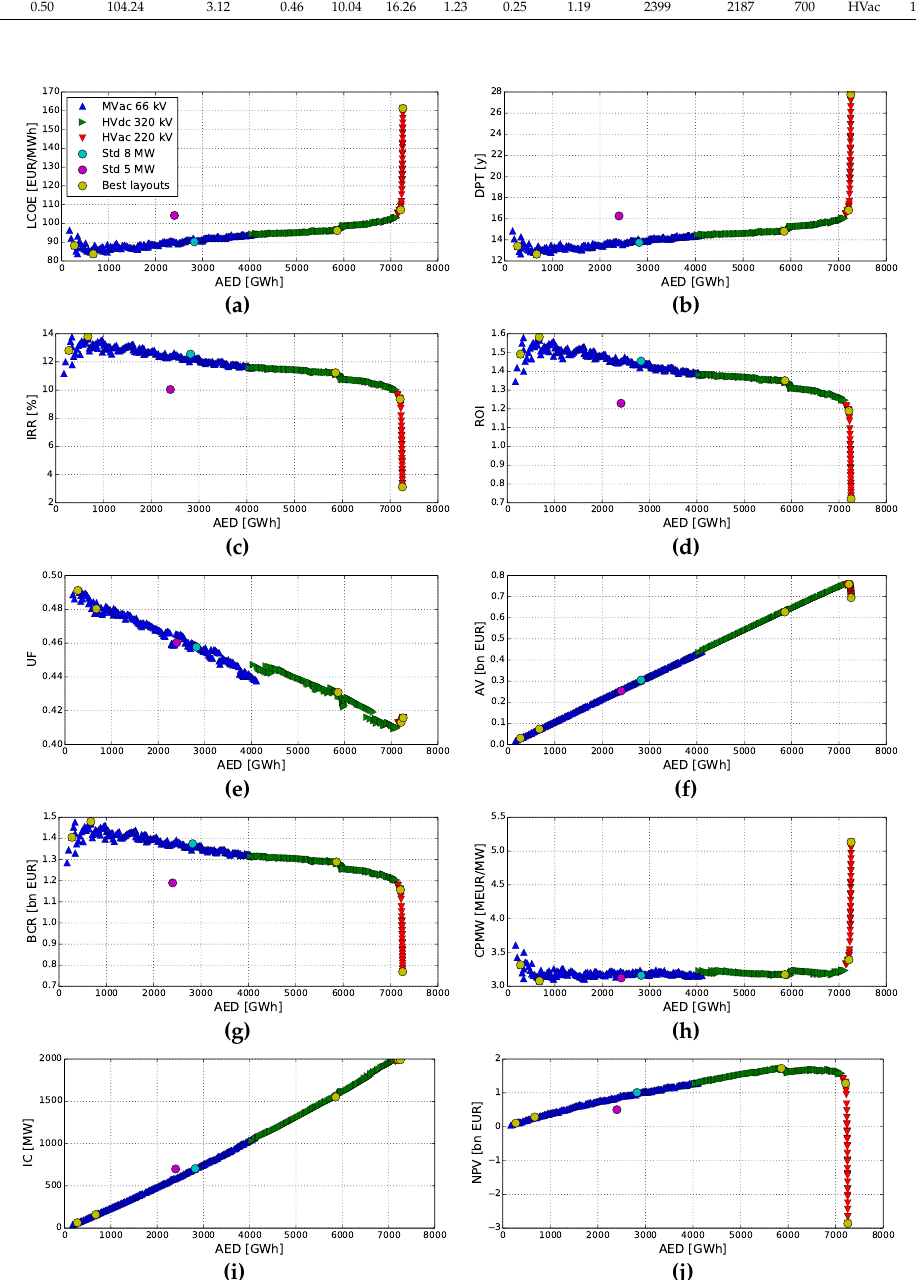
Figure 18. Results obtained for the different economic functions of the layouts of the optimized trade-off. The values obtained with the standard layouts are also shown. ( a ) levelized cost of energy (LCOE); ( b ) discounted payback time (DPT); ( c ) Internal rate of return (IRR); ( d ) return on investment (ROI); ( e ) utilization factor (UF); ( f ) annualized value (AV); ( g ) benefit to cost ratio (BCR); ( h ) cost of power (COP); ( i ) Installed capacity; ( j ) net present value